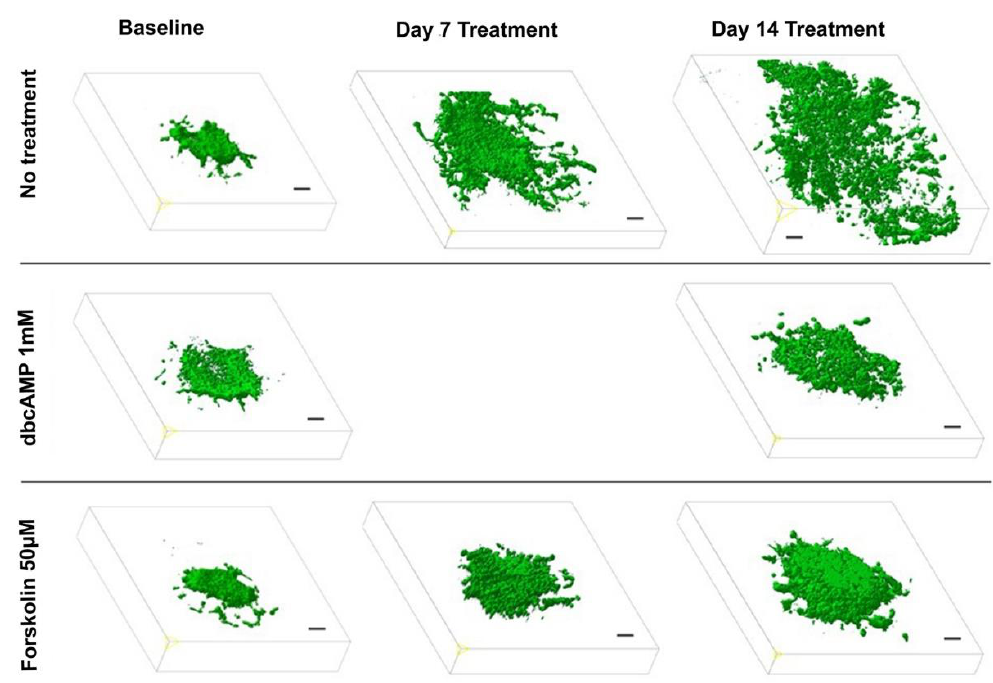
Figure 4. Effect of differentiation therapy on the tumor volume of the glioblastoma cell line U87 co-cultured with organotypic brain slices as quantified by two-photon fluorescence microscopy. 3D images of U87GFP+ cells transplanted bilaterally onto the CA3 region of the hippocampus before, 7, and 14 days after treatment with the cyclic AMP analog dibutyryl cAMP and the cAMP activator forskolin. Scale bars represent 100 µm.